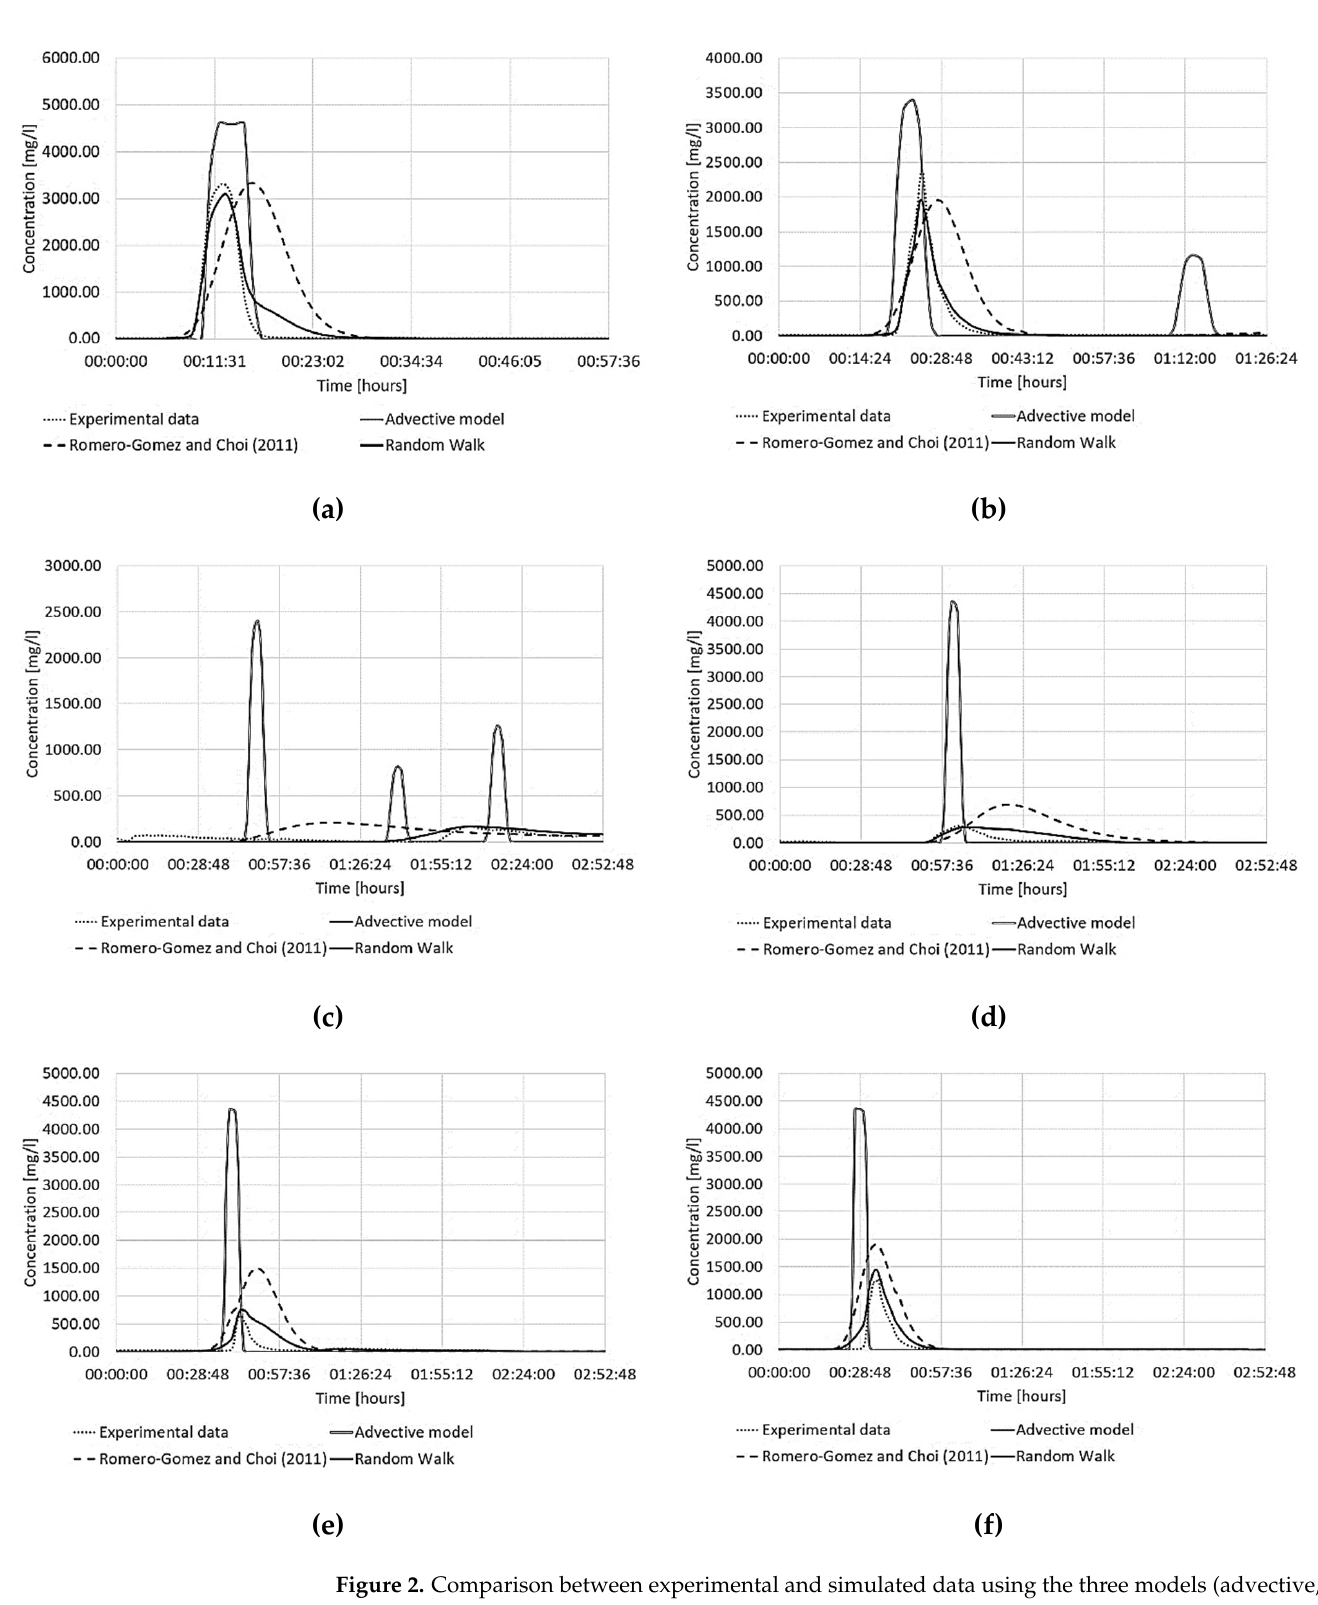
Figure 2. Comparison between experimental and simulated data using the three models (advective, Romero-Gomez and Choi (2011) [11] (backwards coefficient = 0.17, forwards coefficient = 0.51), EPANET-DD (backwards coefficient = 0.17, forwards coefficient = 0.51)) for a contamination event lasting 3 h subject to a network pressure of 1.5 bar for nodes 6 ( a ), 7 ( b ), 8 ( c ), 9 ( d ), 10 ( e ), 11 ( f ), obtained by contaminating node 5.